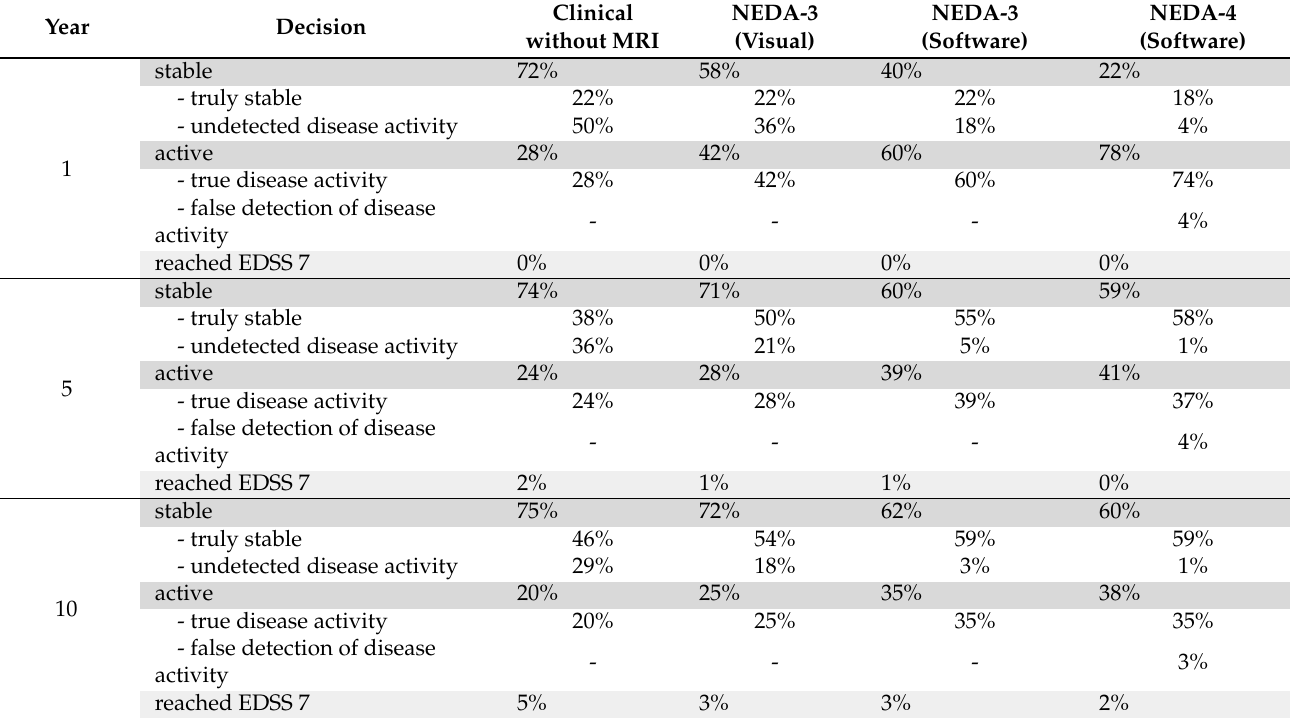
Table 3. The proportion of patients detected as stable or active in the four decision-making strategies. Results are reported for several model horizons, namely after the first cycle, and averaged over the first 5, and 10 cycles/years. No decisions are reported for patients who reached EDSS 7, but their respective proportions are listed for each strategy.